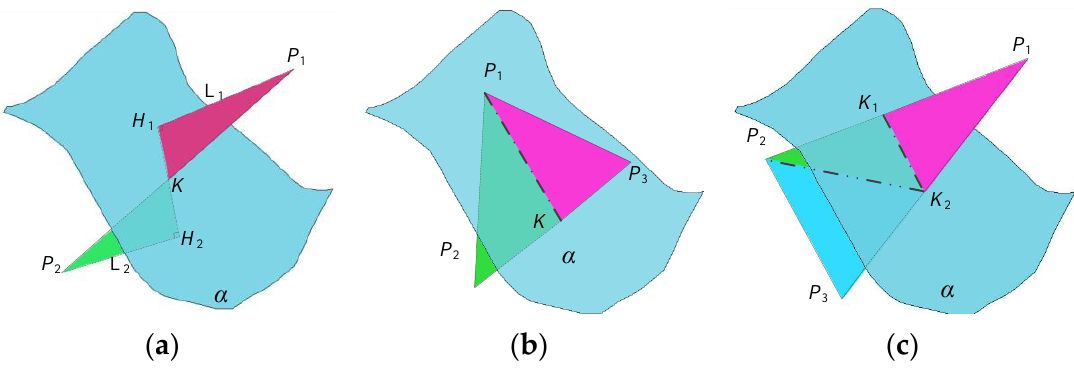
Figure 6. Surface-related intersections. ( a ) The segment intersects the HRBF surface; ( b ) a triangle with one point on the surface intersects the surface; and ( c ) a triangle with no points on the surface intersects the surface.